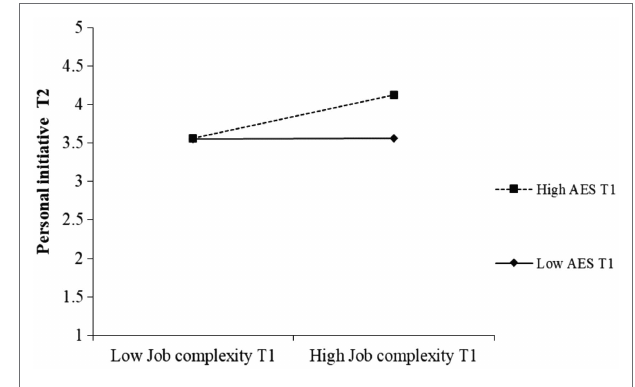
FIGURE 2 | The moderating effect of aesthetic sensitivity (AES) on the relationship between job complexity T1 and employee task proactivity T2 (Study